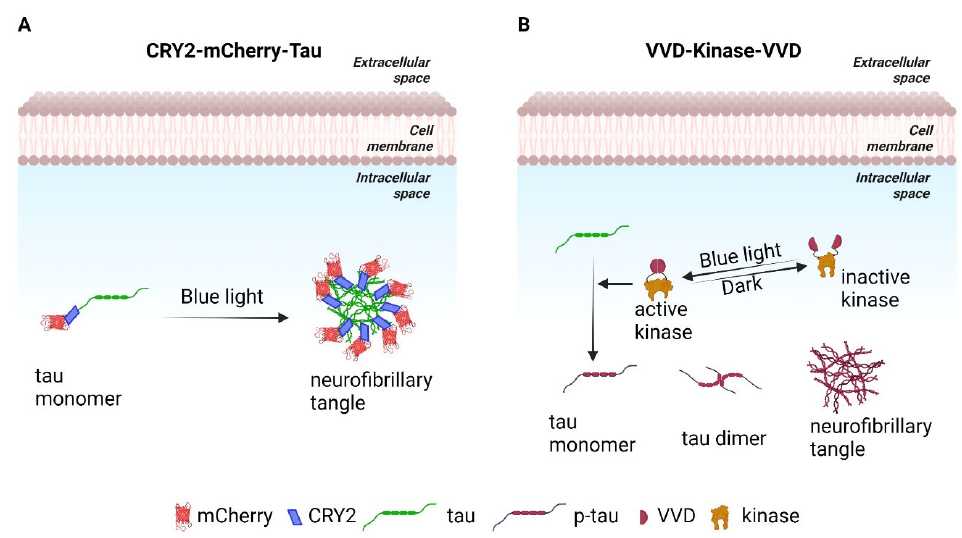
Figure 4. Strategies for making tau-aggregates. ( A ) A construct of CRY2-mCherry-tau that will respond to blue light to form tau aggregates. ( B ) A light activated kinase to phosphorylate tau forming aggregates.